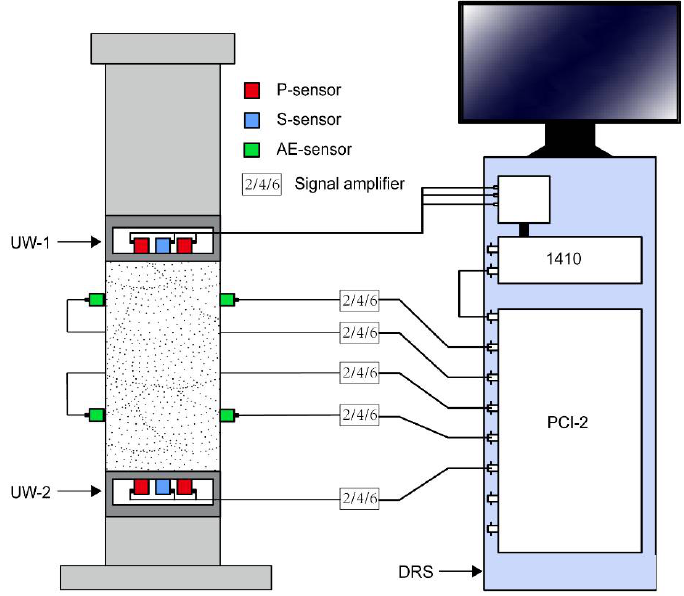
Figure 1. Schematic of integrated testing of ultrasonic waves and acoustic emissions for rock under uniaxial stress. AE, acoustic emissions; PCI, peripheral component interconnect; P-sensor, pressure wave sensor; S-sensor, shear wave sensor; UW-1, ultrasonic wave system part #1; UW-2, ultrasonic wave system part #2.